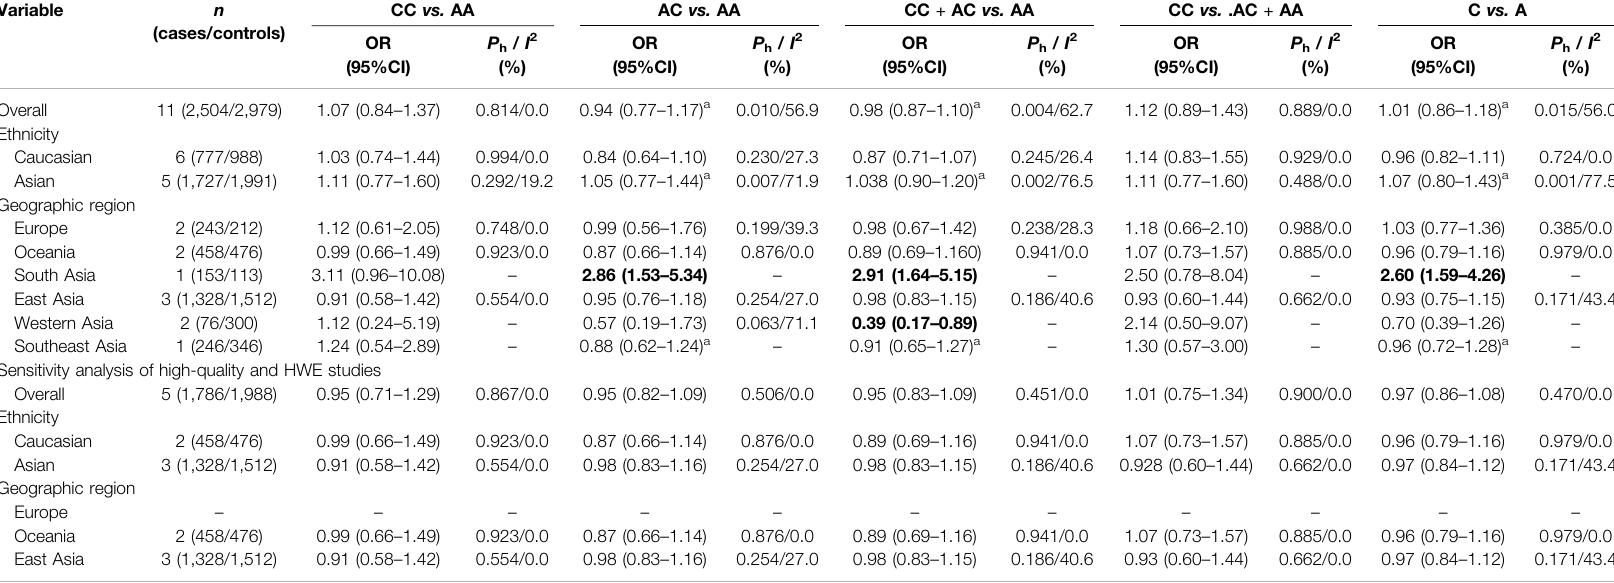
TABLE 6 | Pooled results and sensitivity analysis of the association between MTHFR A1298C polymorphism and essential hypertension. The meaning of bold is in different subgroups, there are statistically signi fi cant gene models. In other words, it is the genetic model associated with EH.